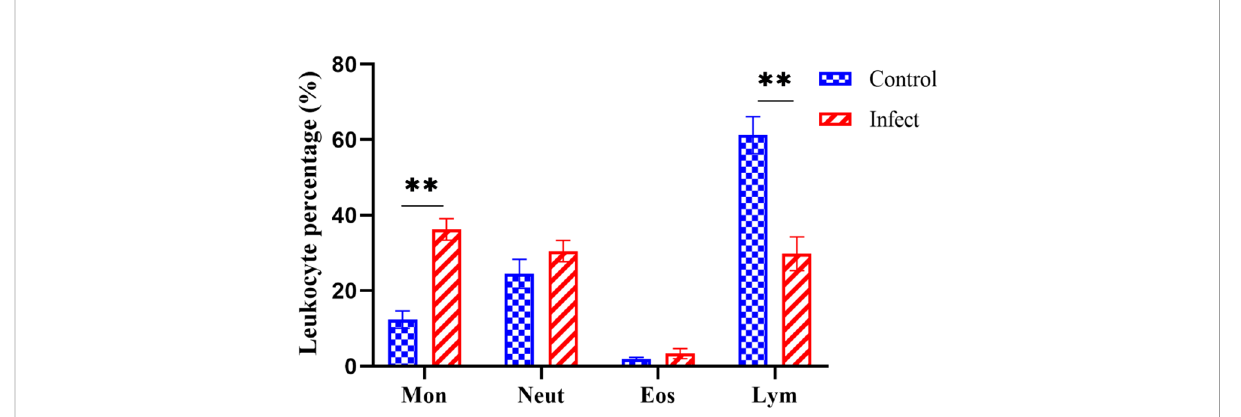
FIGURE 6 Differential white blood cell count. Mon: monocytes; Neut: neutrophils; Eos: eosinophils; Lym: lymphocytes; the proportion of monocytes was signi fi cantly increased ( P < 0.01) and the proportion of lymphocytes was signi fi cantly decreased ( P < 0.01) in diseased sturgeons. Although there was a trend of increase in neutrophils and eosinophils, it was not statistically signi fi cant ( P > 0.05). ** p <